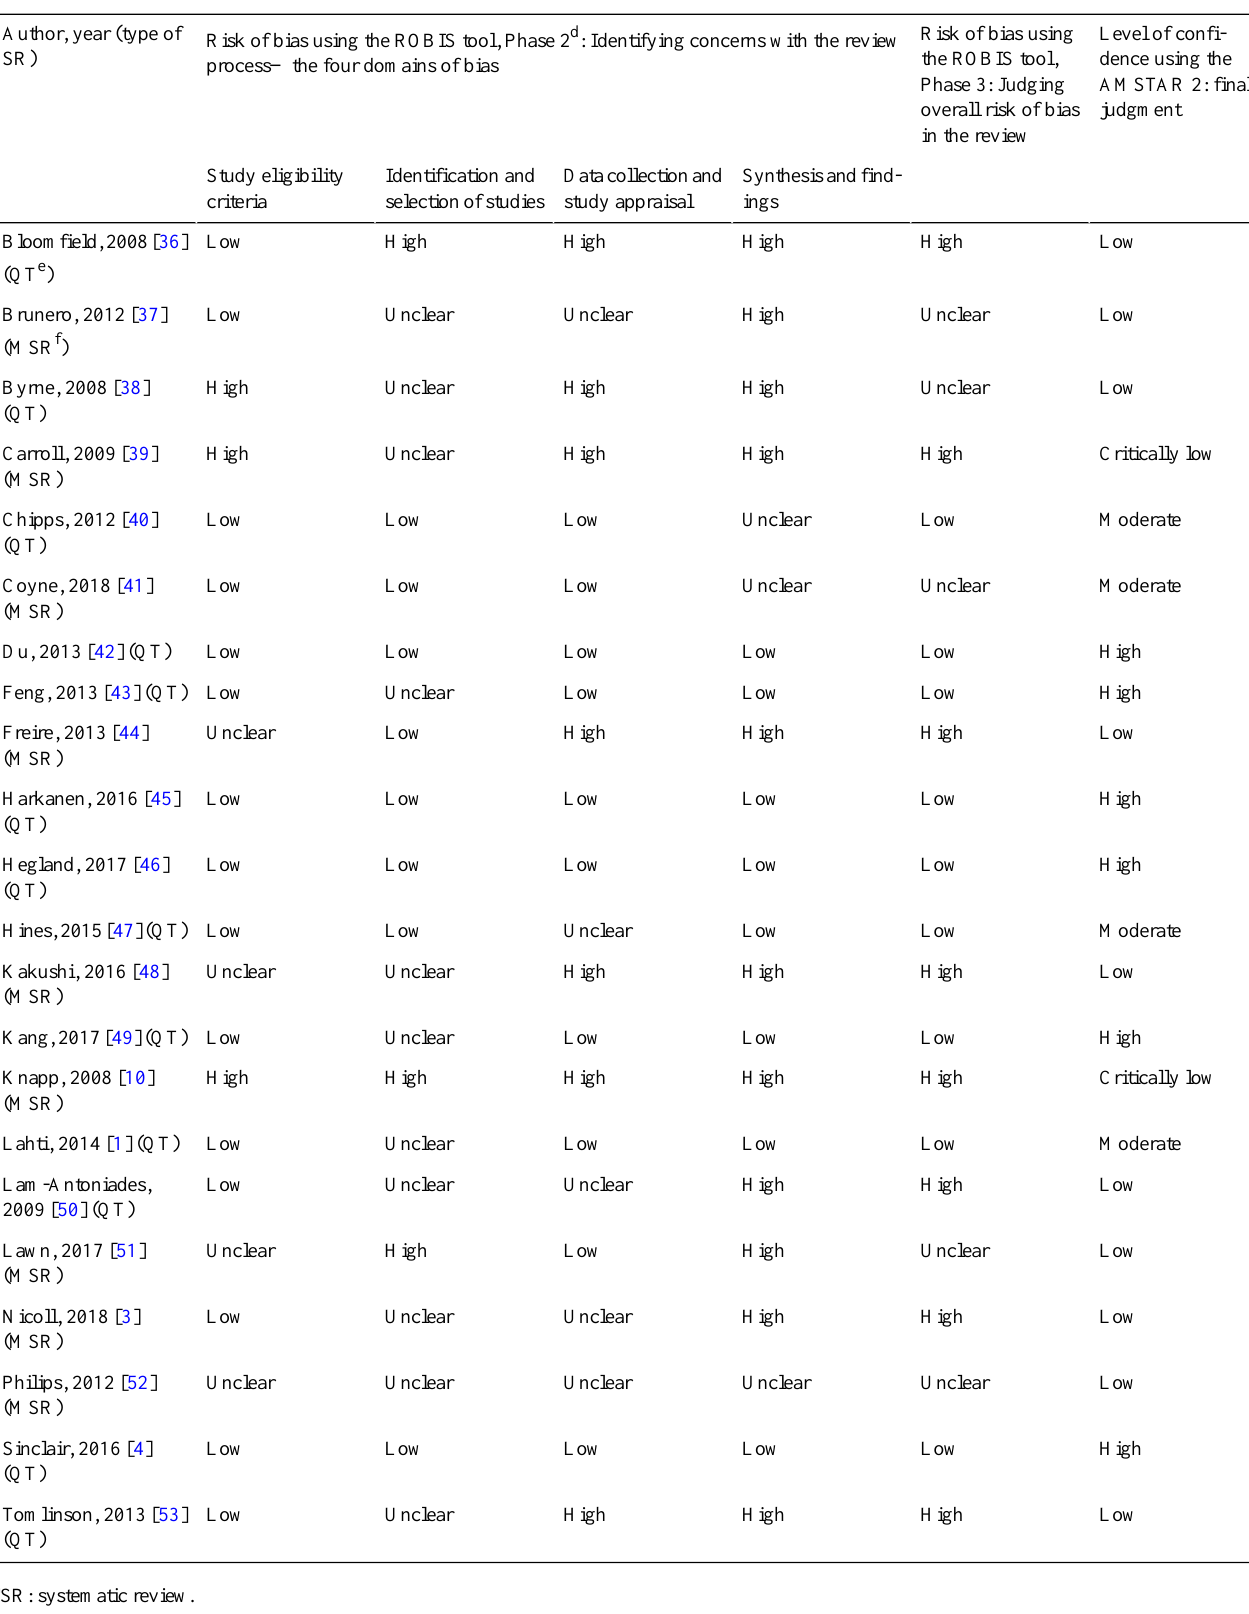
Table 2. Methodological quality assessment for each individual SR a included in this study using a combination of the ROBIS b tool and the AMSTAR c